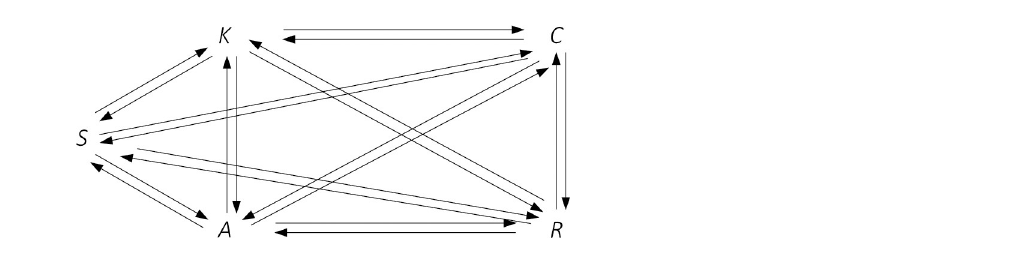
Fig 4. Primary model for variable link analysis. Source: Own study.